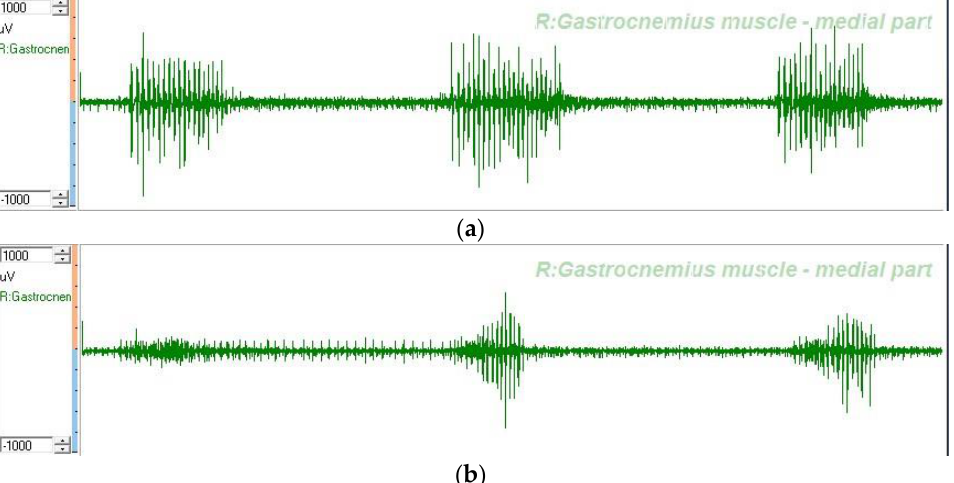
Figure 5. Depiction of dEMGs from right gastrocnemius-medial part. ( a ) Stretch reflex dEMG after wearing a PAFO. ( b ) Stretch reflex dEMG after wearing an AAFO. Abbreviations: R, right; AAFO, anterior ankle foot orthosis; PAFO, posterior ankle foot orthosis; dEMG, dynamic